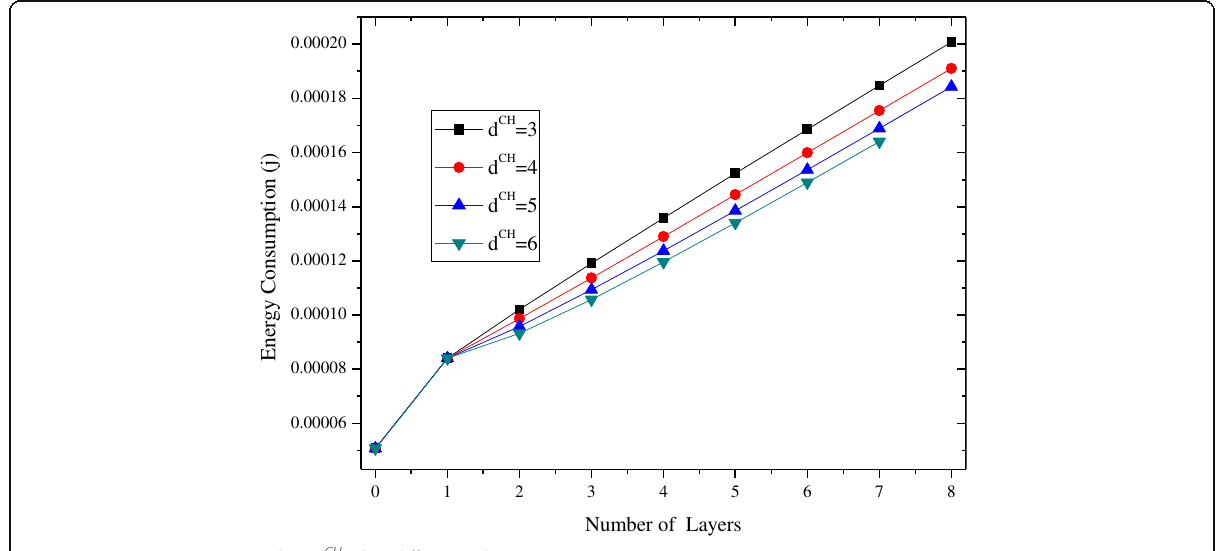
Fig. 15 Energy consumption when d CH takes different